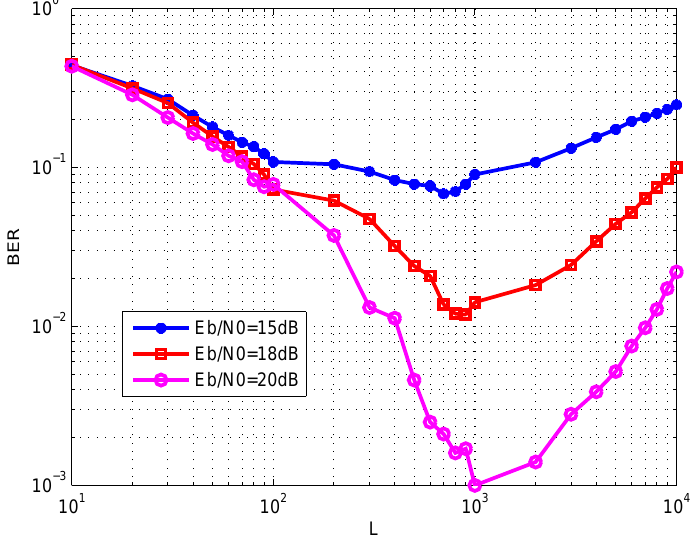
Figure 6. BER performance versus spreading gain L for the proposed